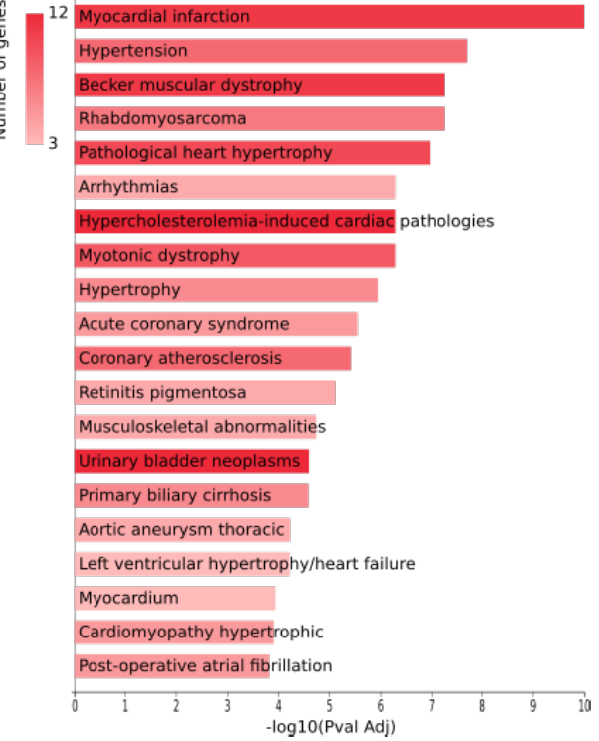
Figure 2. GeneCodis4 bars chart plot of the MNDR database in the direct annotation of miRNAs strategy. 15 out of 20 are heart-related disorders.